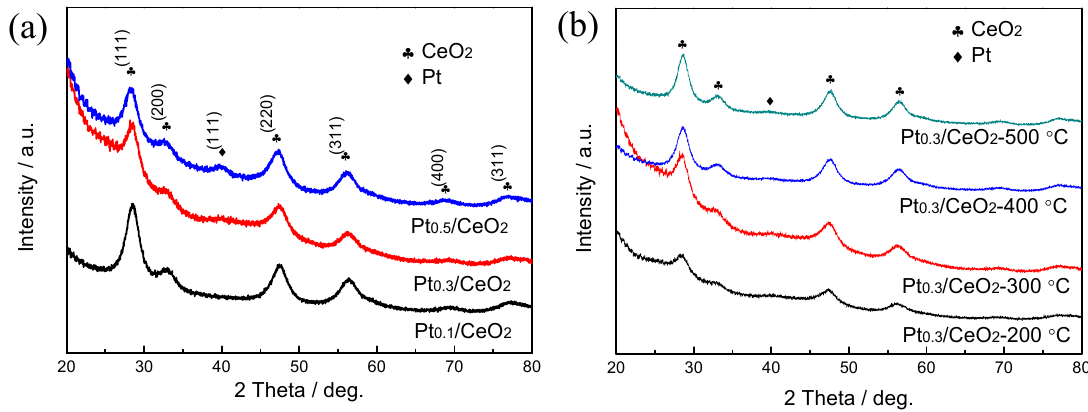
Figure 1. XRD patterns of ( a ) dealloyed Al 91.9 Ce 8 Pt 0.1 , Al 91.7 Ce8Pt 0.3 and Al 91.5 Ce 8 Pt 0.5 ribbons calcined at 300 °C and ( b ) dealloyed Al 91.7 Ce 8 Pt 0.3 ribbons calcined at 200, 300, 400 and 500 °C. The surface morphologies of the dealloyed and calcined Al 91.9 Ce 8 Pt 0.1 , Al 91.7 Ce 8 Pt 0.3